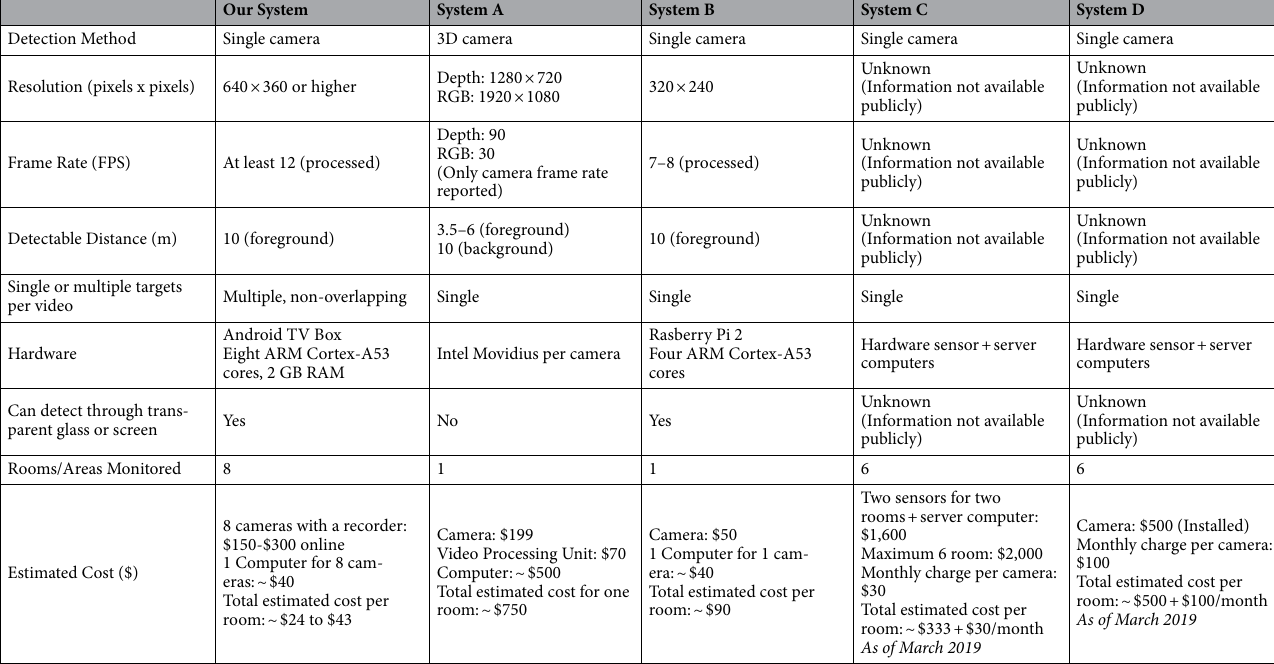
Table 2. Comparisons of performance and cost of our system with the previously published works or current commercial